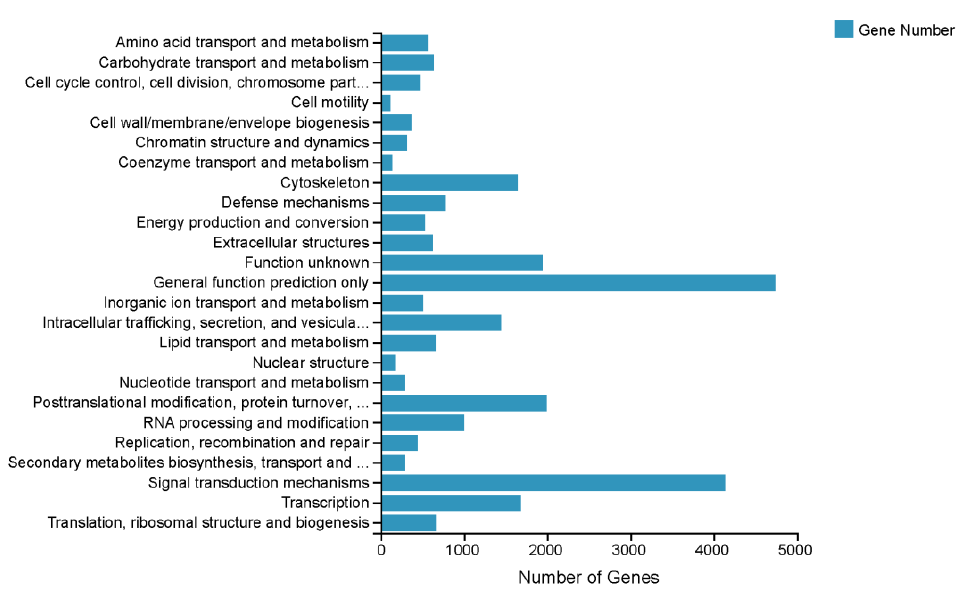
Figure 2. KEGG pathway classifications of the unigenes.